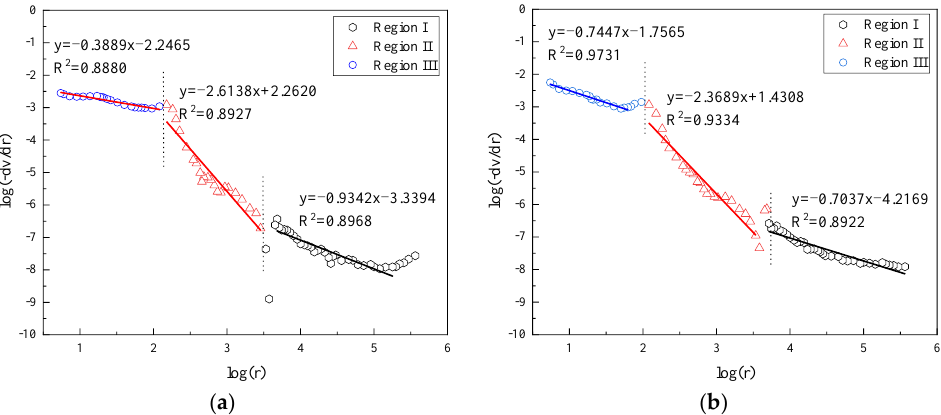
Figure 15. Multifractal characteristics of FCP10 at different ages under Pfeifer and Avnir’s model. ( a ) 3 days, ( b ) 28 days.